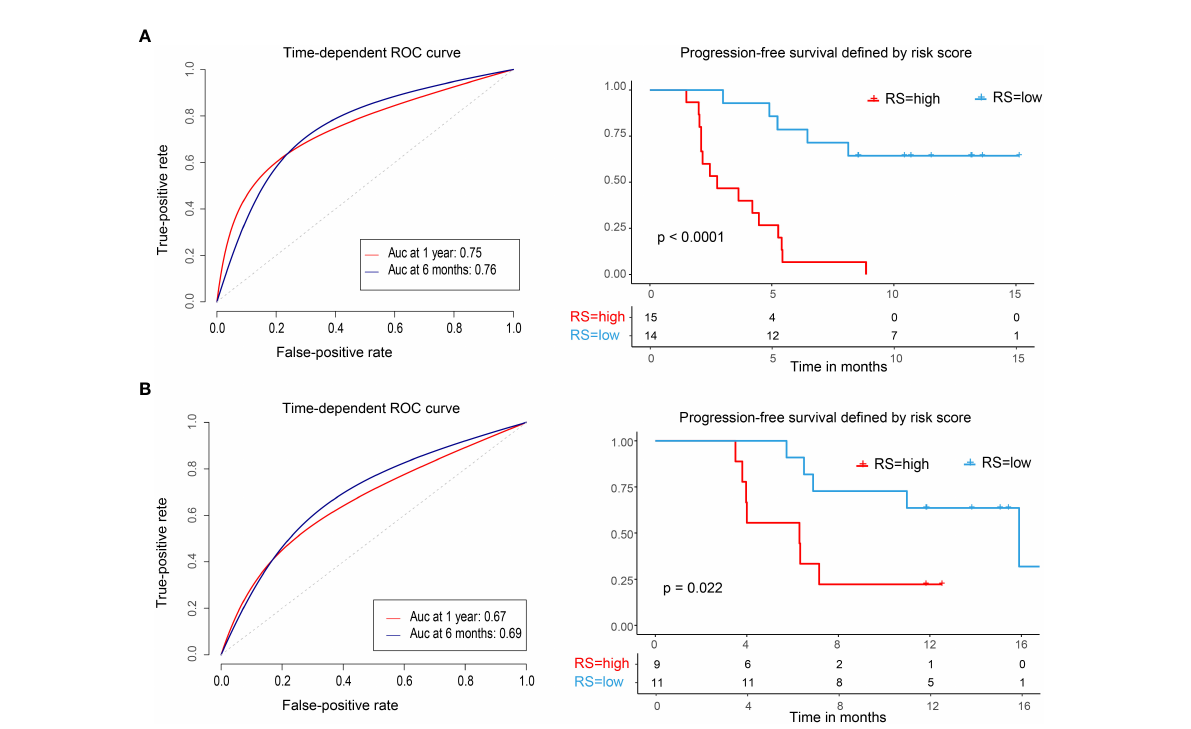
FIGURE 3 Time-dependent ROC curves, Kaplan – Meier survival curves in the training set and validation set. ROC, receiver operator characteristic; AUC, area under the curve. (A) Training cohort. (B) Validation cohort. We used AUCs at 0.5 and 1 years to assess prognostic accuracy and calculated P values using the log-rank